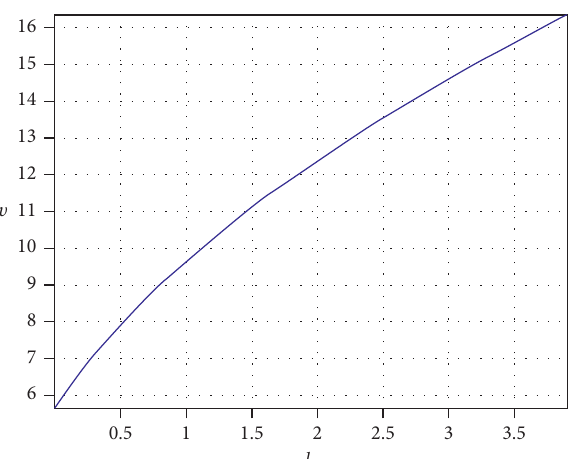
� 0 . 82 , κ � 10 5 , the critical flow velocity versus the nondimensional b